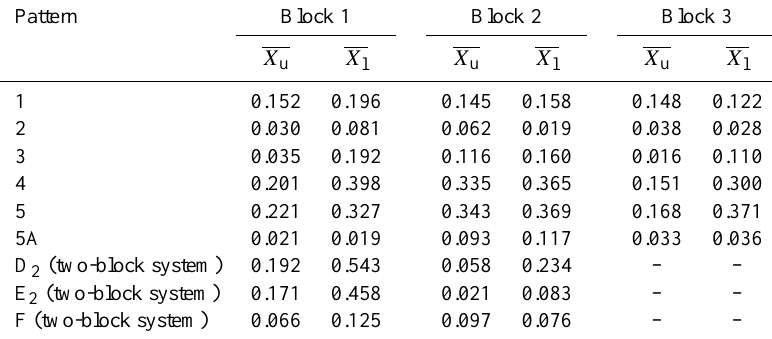
Table 3. The average values of the displacement differences X u and X l for slip patterns 1–5 and an intermittent slip pattern (pattern 5A) in the three-block system, and patterns D 2 , E 2 , and F in the two-block system (Paper 1). See main text for the definitions of X u and X l . The model parameters for patterns 1–5 are the same as those for Figs. 6, 8, 10, 12, and 13, respectively. The values are calculated for the time period 0–15000 years. Patterns 3 and 5 are calculated for time intervals including both patterns A and B. The model parameters for patterns D 2 , E 2 , and F are the same as those for Figs. 6c, 7c, and 8 in Paper 1, respectively. Pattern Block